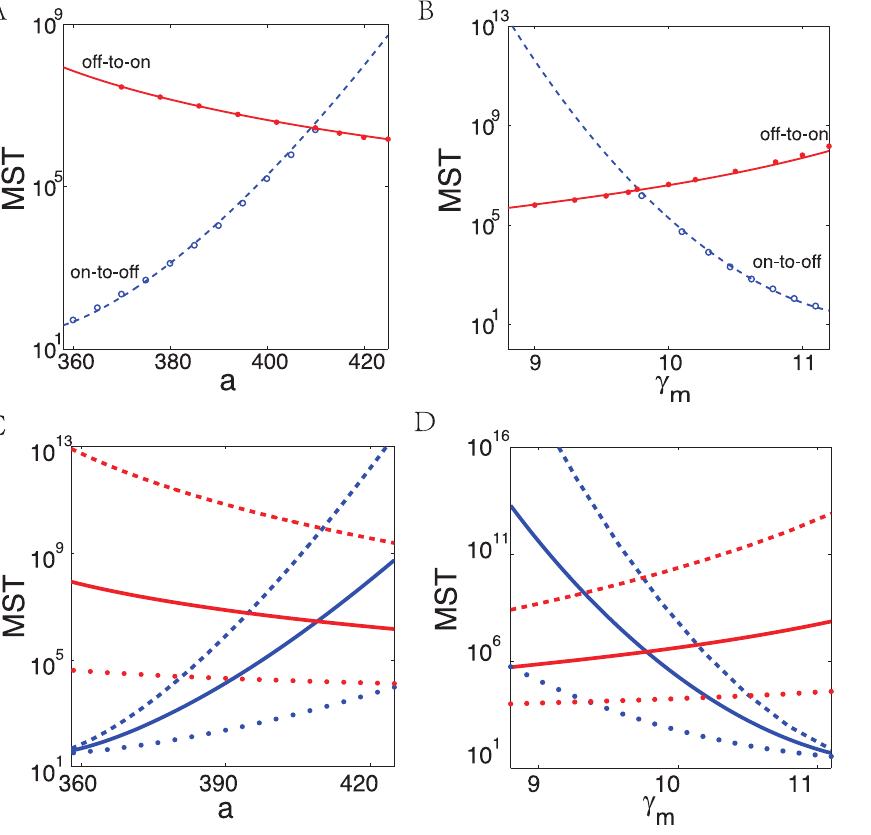
Figure 4. The mean switching time (MST) and quasipotential energy landscape as a function of parameters. (A) and (B): MST as a function of transcription rate a . Promoter transition rates k 0 ~ 1, c 0 ~ 50 , the gMAM results with numerical prefactor of off-to-on transition (red solid line) and on-to-off transition (blue dashed line), compared with MC simulations ( . ) and ( 0 ), respectively. (C) and (D): The gMAM results with different promoter transition rates of off-to-on transition (red) and on-to-off transition (blue), where solid line with k 0 ~ 1, c 0 ~ 50 is same as (A) and (B), the faster transition rate in dashed line with k 0 ~ 5, c 0 ~ 250 , the slower transition rate in dotted line with k 0 ~ 0 : 2, c 0 ~ 10 . Other parameters are a 0 ~ 0 : 4, b ~ 40, c n ~ 1, k 1 ~ 0 : 0002, c 1 ~ 2 ; in (A,C), c m ~ 10 and (B,D) a ~ 400 : of off-to-on transition (red dashed lines) while fast rates lead to long MST of off-to-on transition (red dash-dotted lines). This is due to